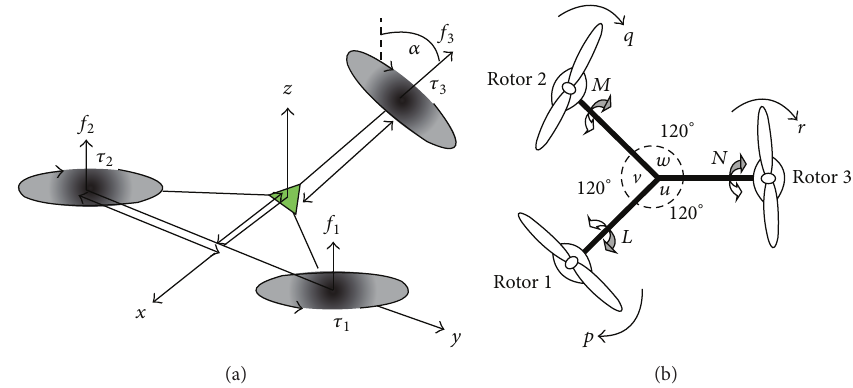
Figure 1: Arrangement of trirotor UAV with (a) tilt angle and (b) system parameters.